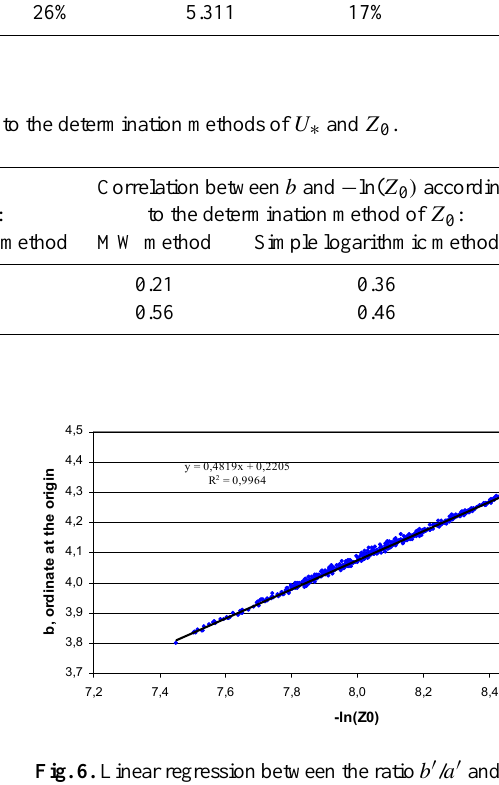
Table 4. Linear regression parameters of the function σ 2